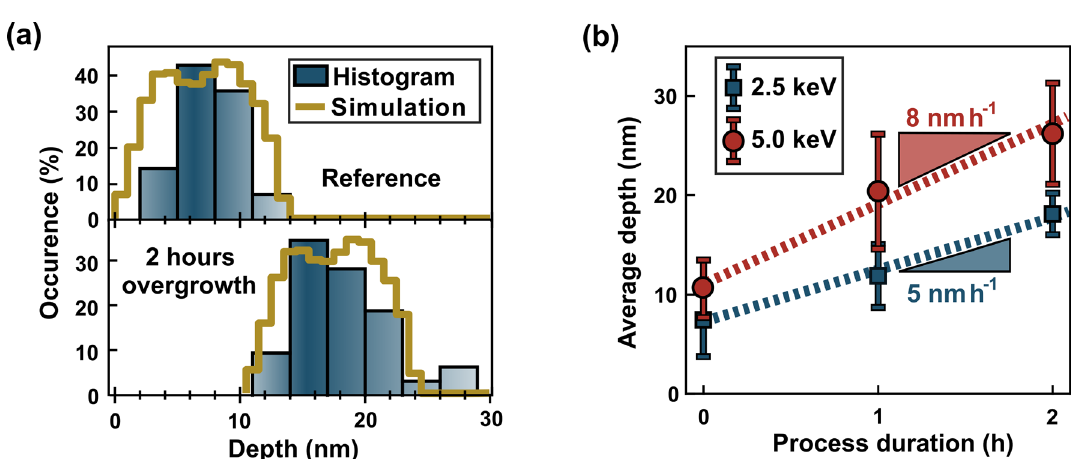
Figure 2. The change in depth of the fabricated NV − centers as a result of CVD-diamond overgrowth. ( a ) Histograms showing the depth distribution of single NV − centers in the reference sample implanted with the low dose (2.5 keV, 10 9 15 N + / cm 2 ) and a second sample with the medium dose (2.5 keV, 10 11 15 N + / cm 2 ) after indirect overgrowth for 2 h. The depth is calculated from sensing the NMR signal of the 1 H -spins in the immersion oil on top of the diamond sample 42 . The simulated depth distribution from C-TRIM 43 is shifted by 10 nm for the overgrown sample. ( b ) The evolution of the average depth of the NV − centers with increasing overgrowth time for implantation energies of 2.5 keV and 5 keV (medium dose). Zero hours corresponds to the reference sample in ( a ) and the error bars represent the standard deviation. The growth rates are extracted from a linear